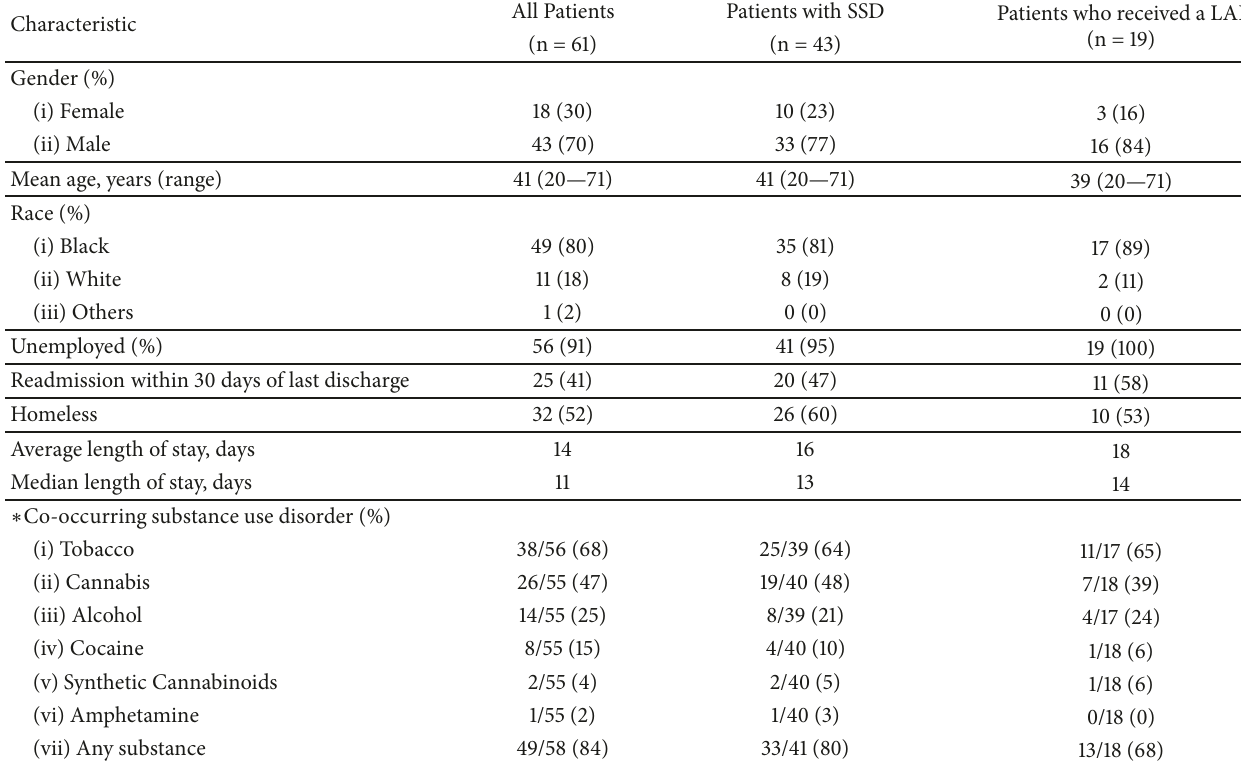
Table 1: Demographic information of study